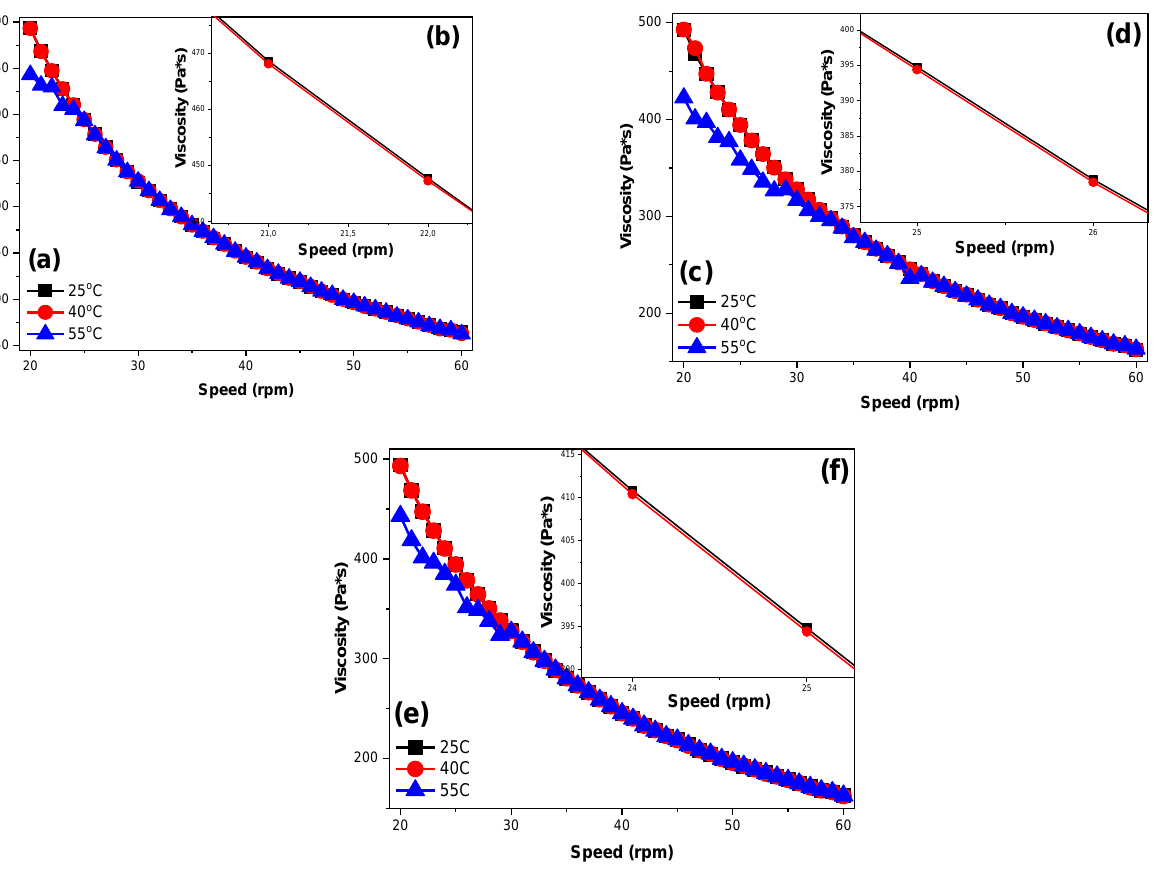
Figure 2. Viscosity dependency over increasing rpm values of the samples: ( a ) CS/VACS/iCR 50/50 20 – 60 rpm, ( b ) CS/VACS/iCR 50/50 21 – 22 rpm, ( c ) CS/VACS/iCR 60/40 20 – 60 rpm, ( d ) CS/VACS/iCR 60/40 25 – 26 rpm, ( e ) CS/VACS/iCR 70/30 20 – 60 rpm, and ( f ) CS/VACS/iCR 70/30 24 – 25 rpm.